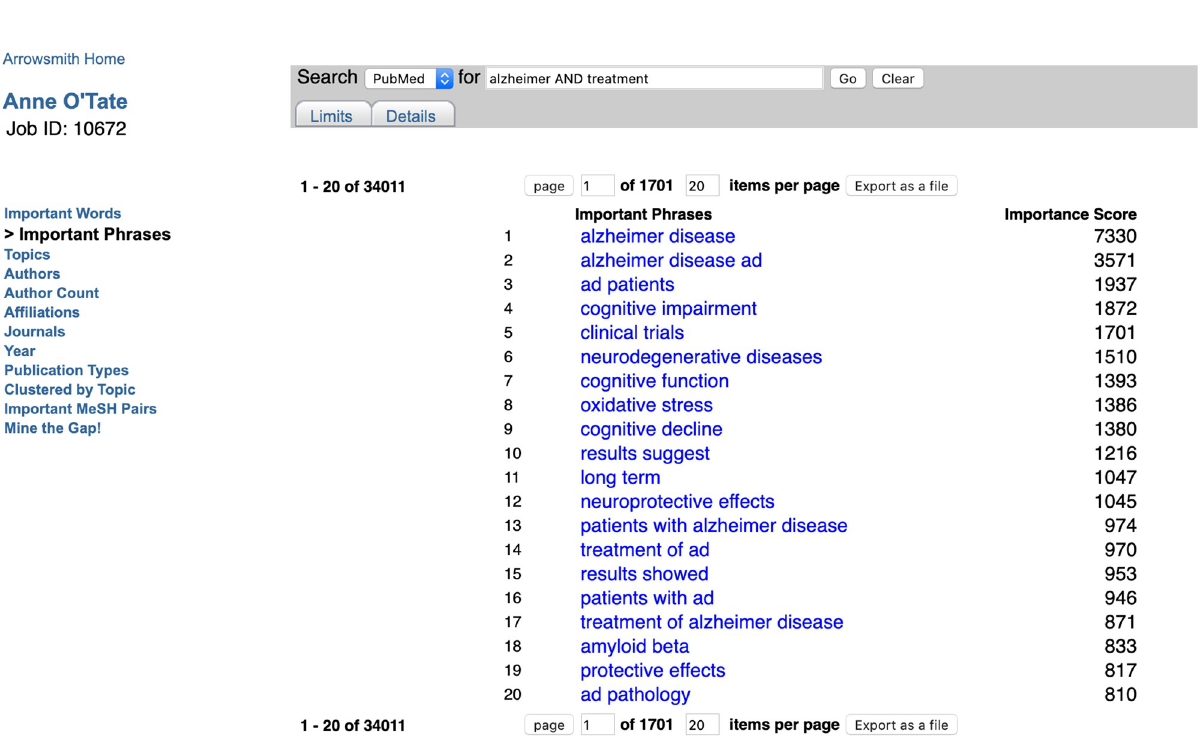
Fig 5. Screenshot of important phrases calculated for the query [Alzheimer AND treatment].